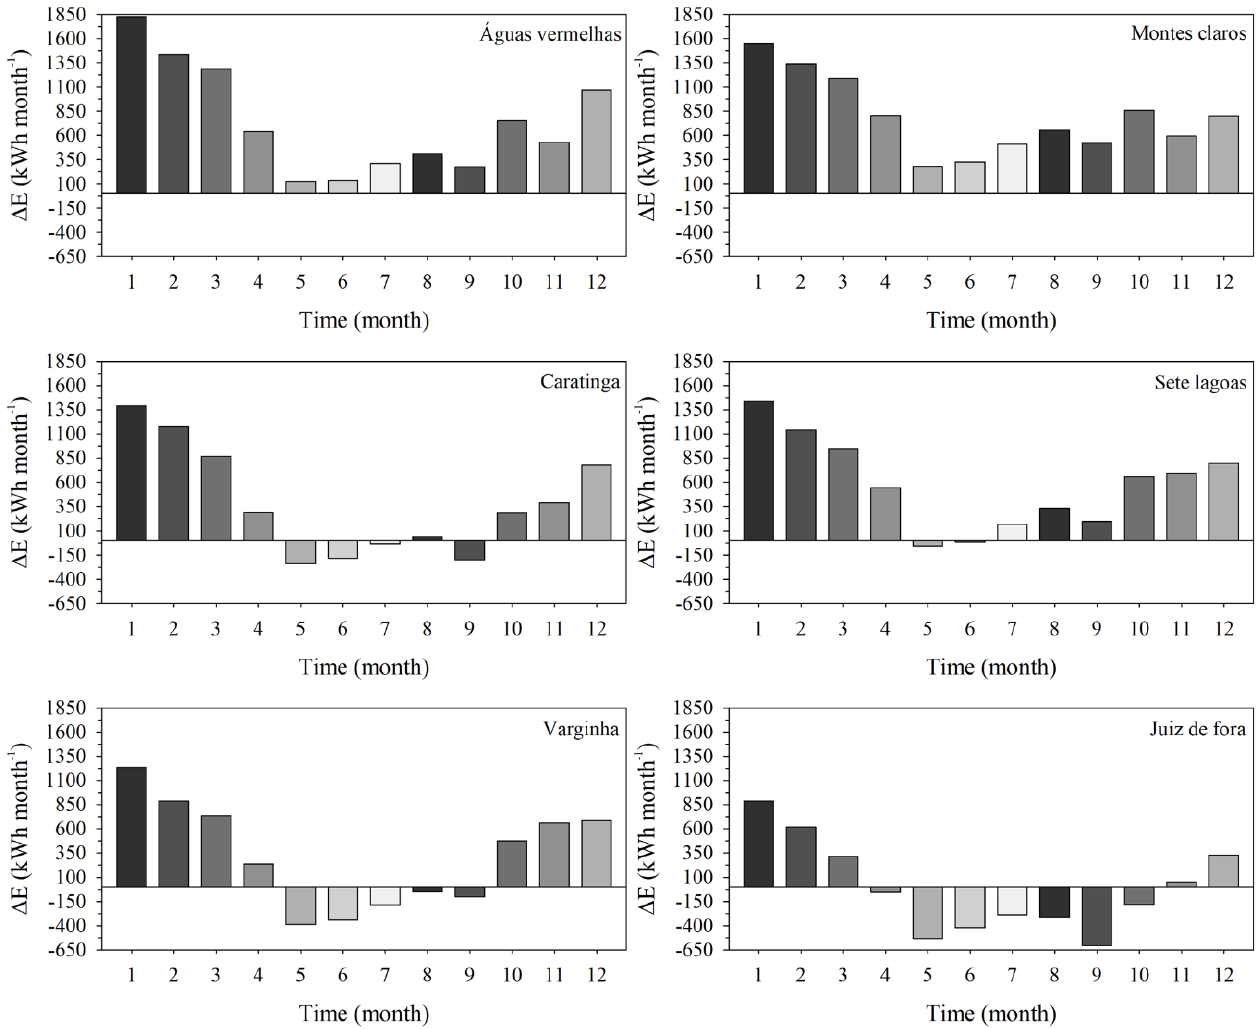
Figure 3. Monthly variations of the difference between the electrical energy generation and the electricity consumption ( ΔE ) for municipalities of Minas Gerais State, Brazil.